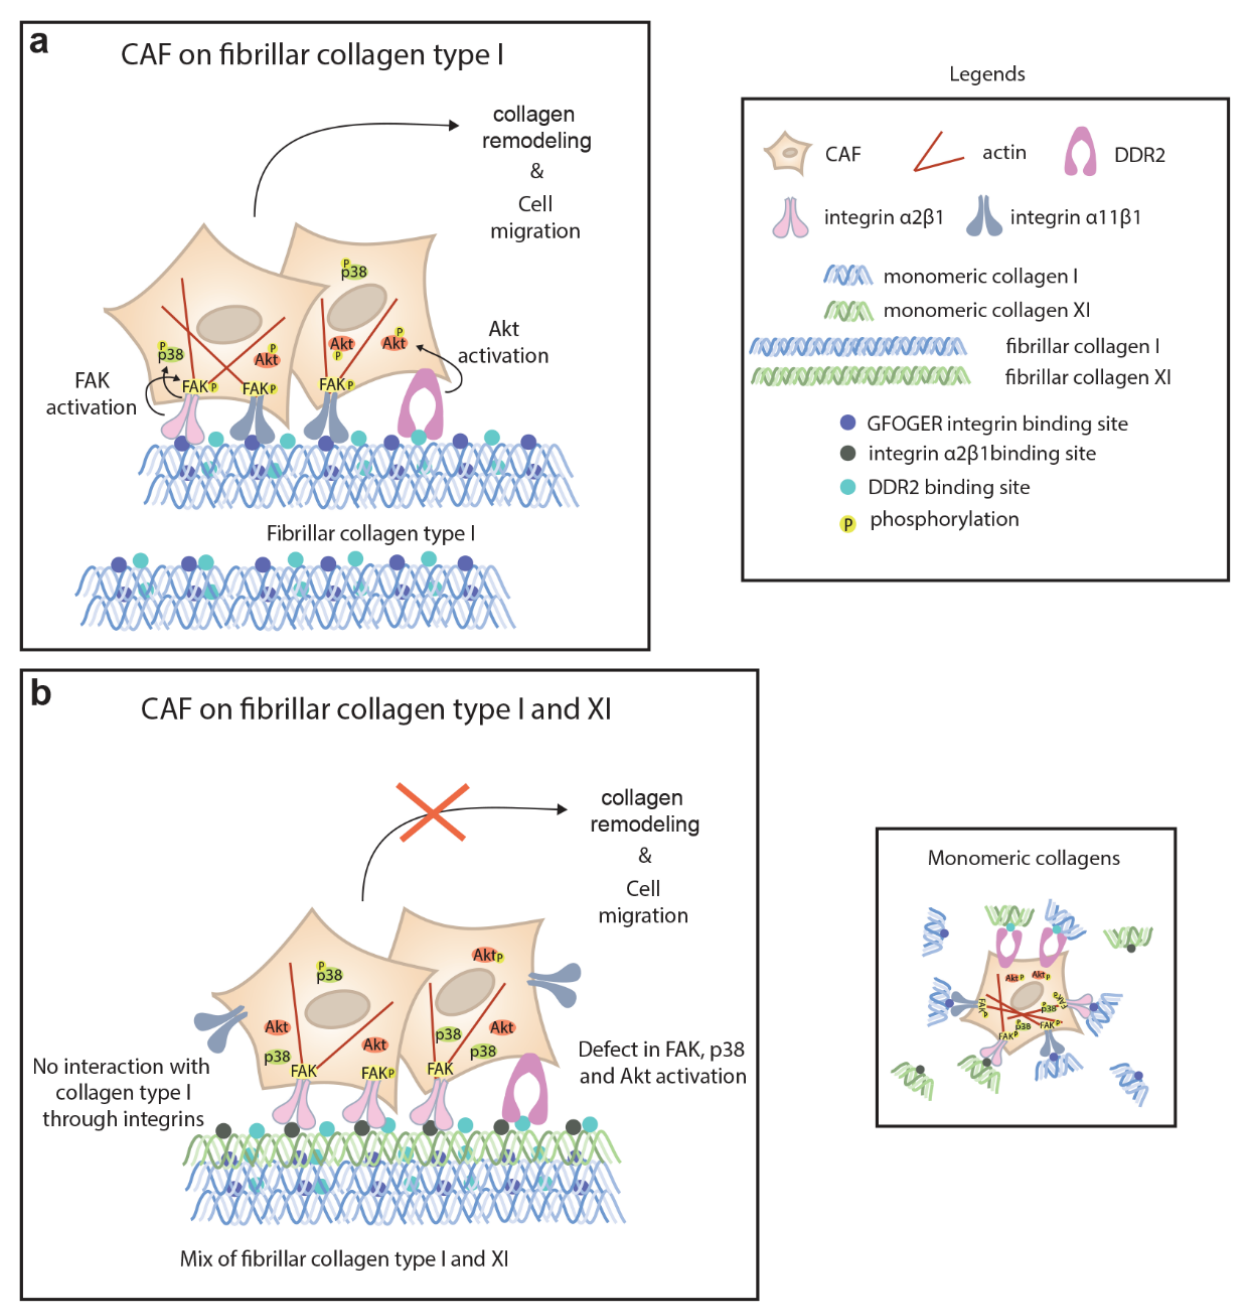
Figure 5. In collagen type I matrices, cancer-associated fibroblasts (CAFs) interact with fibrillar collagen through α 2 β 1 and α 11 β 1 integrins and DDR2 leading to the activation of FAK, p38 and Akt, which in turn promote collagen remodeling and cell migration. ( a ) Both α 2 β 1 and α 11 β 1 integrins recognize the GFOGER motif present in collagen type I. Integrins, via their link to actin cytoskeleton, control cell contractility and motility, whereas DDR2 could modulate integrin activity. In the presence of collagen type XI in collagen type I fibrils, integrin-binding sites on collagen type I are not available, inhibiting integrin α 11 β 1 function. ( b ) Although integrin α 2 β 1 and DDR2 can interact with collagen type XI, there is a defect of FAK and Akt long-term activation, resulting in inhibition of collagen remodeling and cell migration. On monomeric collagen, single molecules of collagen do not interfere between each